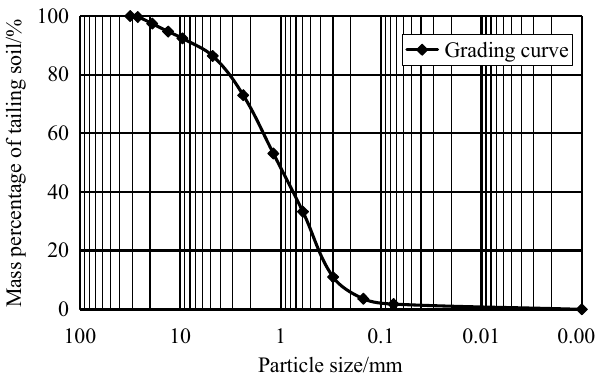
Figure 3. Accumulation curve of grain size gradation of tailings soil.